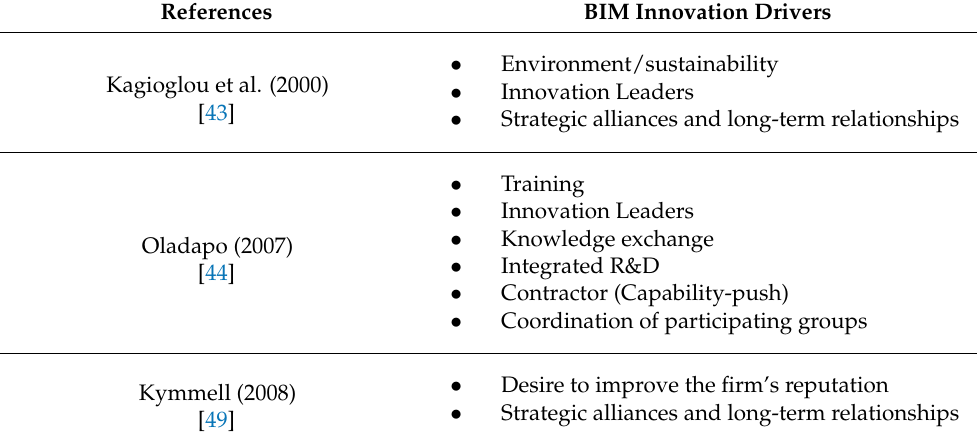
Table 2. The drivers of BIM